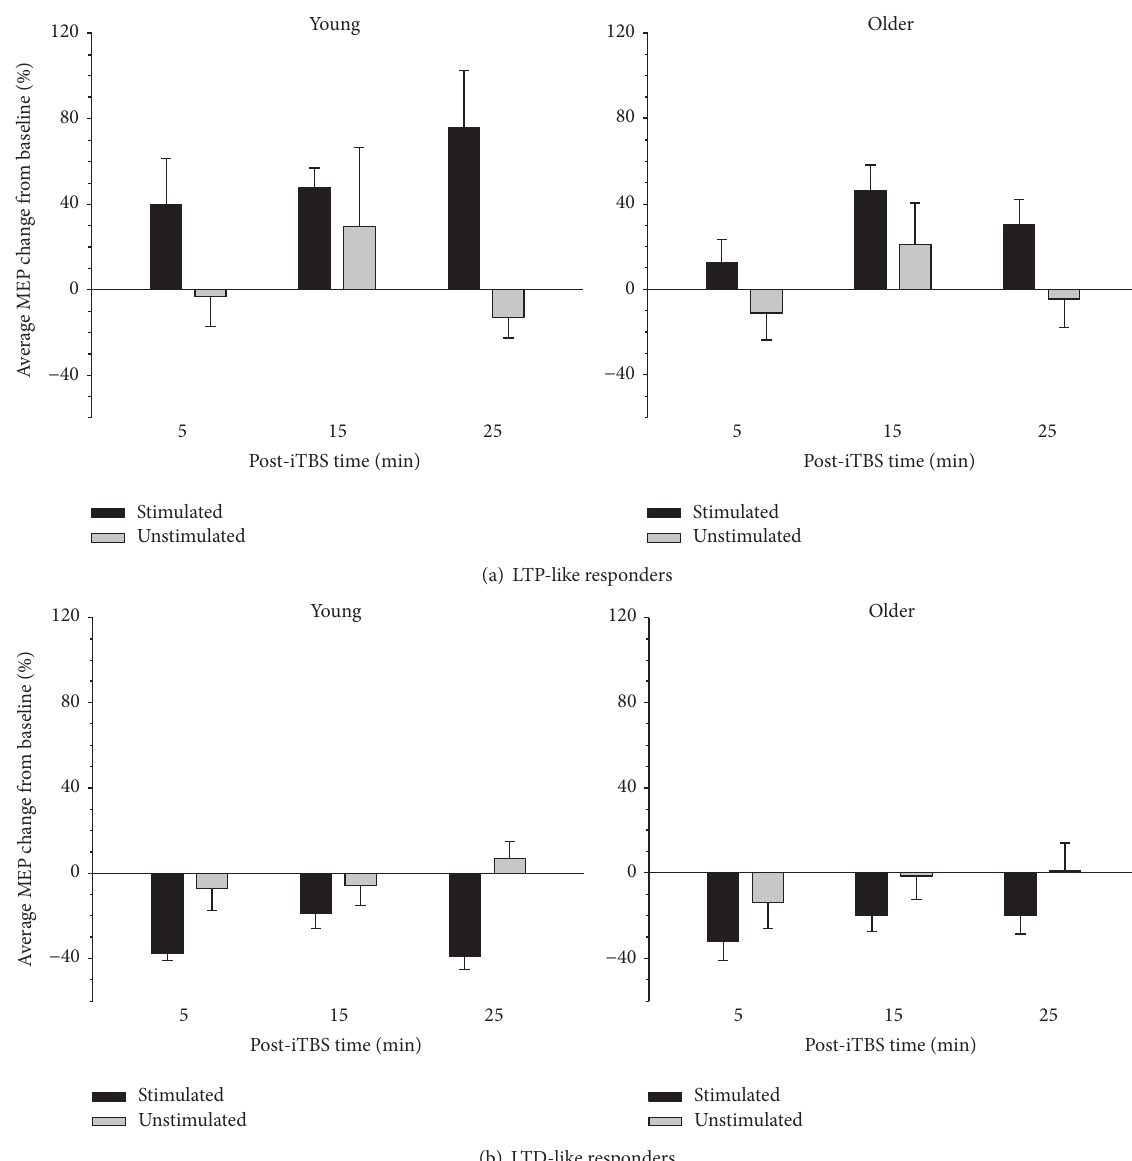
Figure 4: Average normalised MEP change following iTBS in young and older LTP-like (a) and LTD-like (b) responders. In both of the LTP- like and LTD-like responders, MEP change was comparable between young and older adults and was greater in the hemisphere receiving iTBS (stimulated) than the hemisphere not receiving iTBS (unstimulated). Error bars denote SEM .